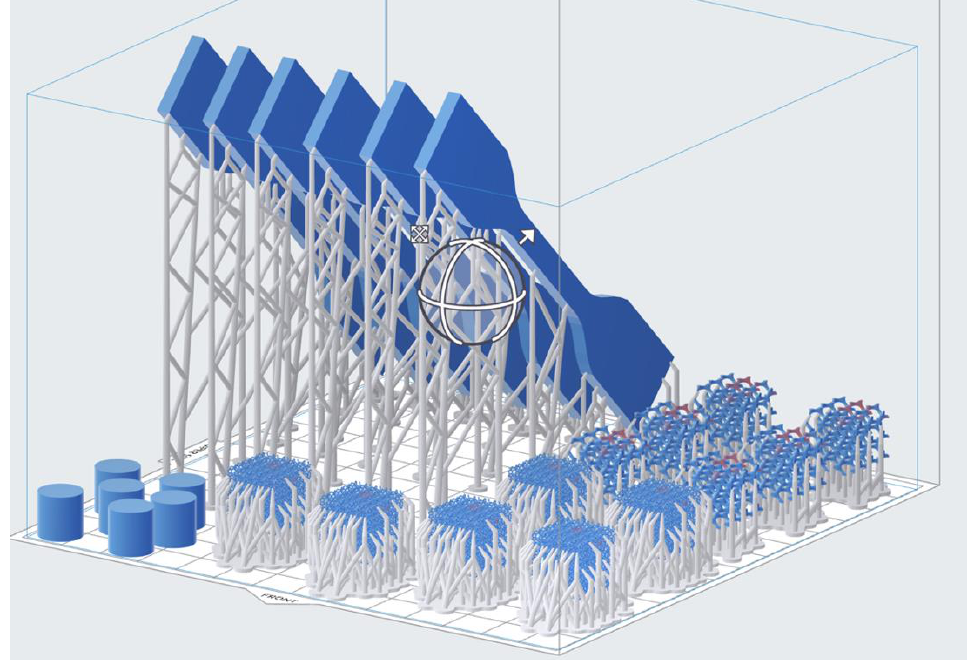
Scheme 1. STL file corresponding to the 3D-printed polymer nanocomposites visualized through PreForm software (Formlabs ®